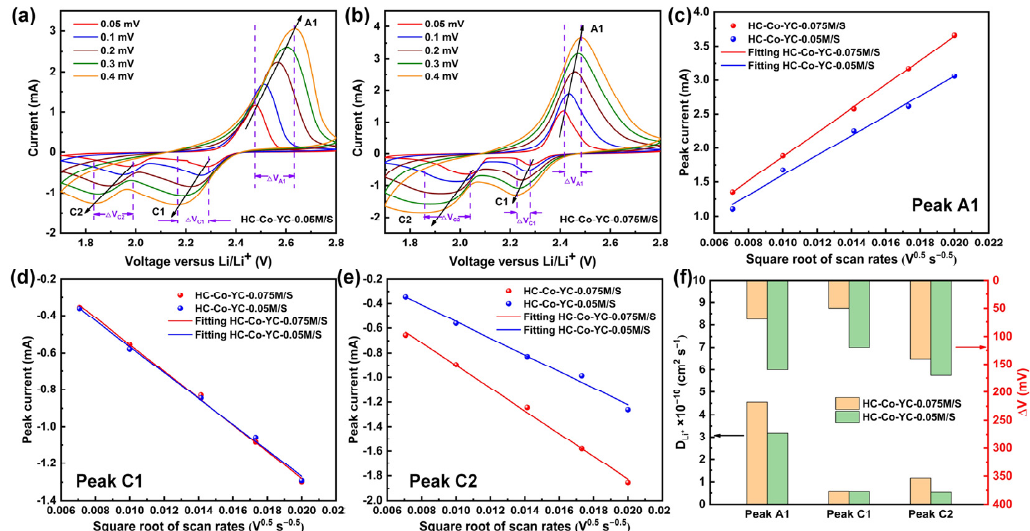
Figure 8. CV curves of ( a ) HC–Co–YC–0.05M/S and ( b ) HC–Co–YC–0.075M/S under different sweep rates of 0.05–0.4 mV s − 1 , ( c – e ) peak currents versus the square root of scan rates of HC–Co–YC–0.05M/S and HC–Co–YC–0.075M/S, and ( f ) polarized voltage and Li-ion diffusion coefficient com-